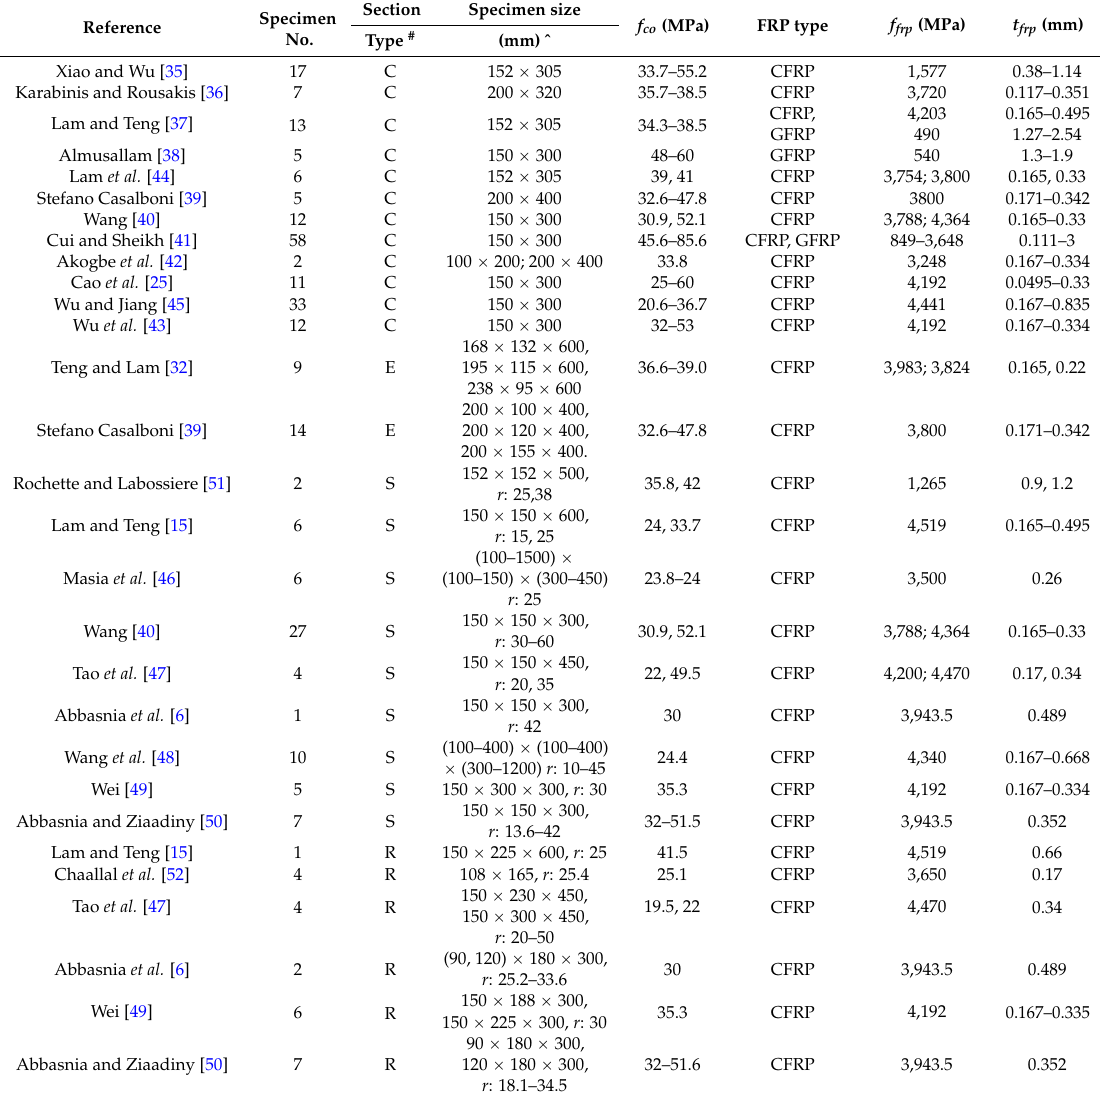
Table 2. The summary of the details of the stress-strain